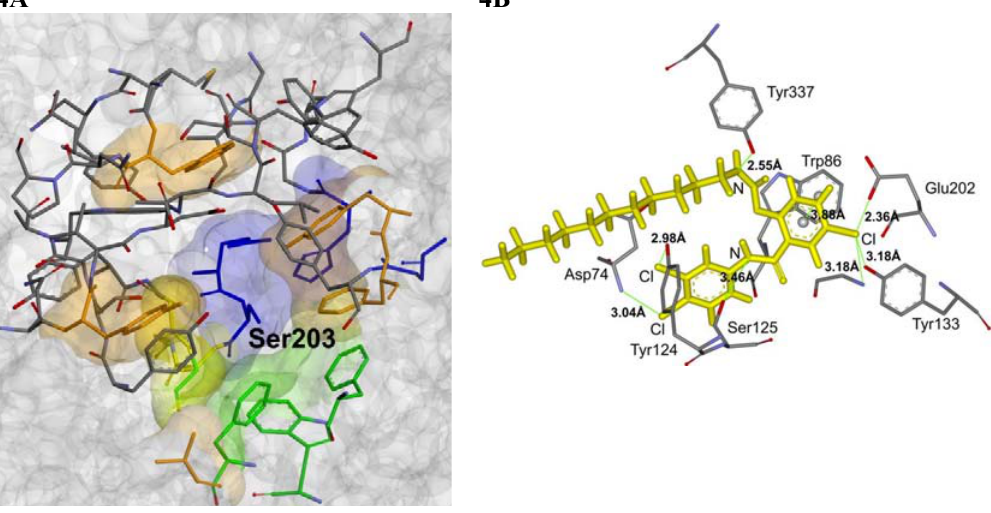
Figure 4. ( A ) Representation of three-dimensional structure of acetylcholinesterase (shown as solvent accessible surface), showing gorge and specific parts of active site (catalytic triad: blue, OAH: yellow, PAS: orange, ABS: green). ( B ) Example of interactions between docked molecule of 6i and amino acid residues within active site gorge. The interacting atoms and amino acid residues are depicted; other parts of the active site gorge are omitted for clarity.